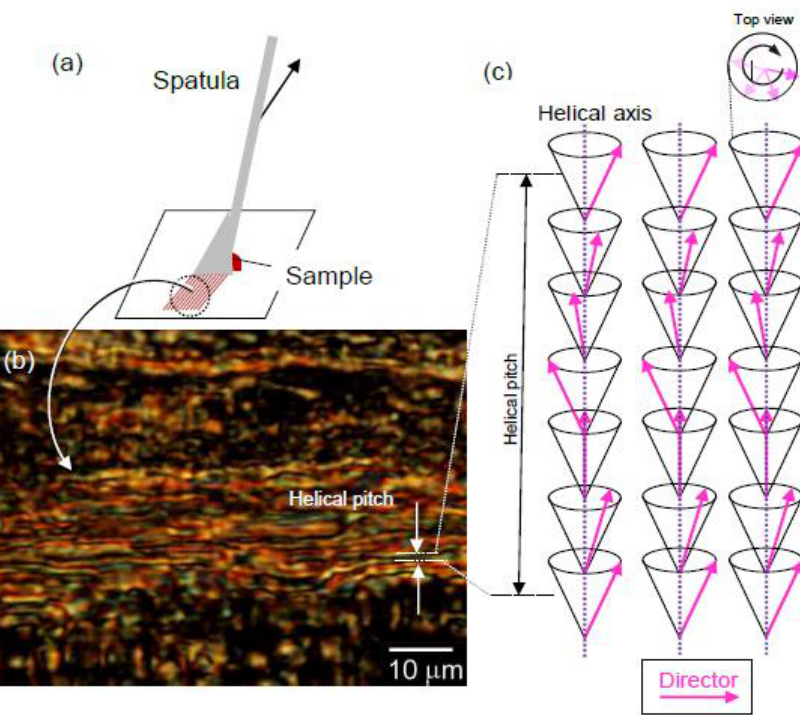
Figure 15. ( a ) Mechanical orientation of the SmC*–LC–poly(Ac–Pyr) blend using a spatula. ( b ) POM image of the oriented SmC*–LC–poly(Ac–Pyr) blend. ( c ) The helical superstructure of the SmC*